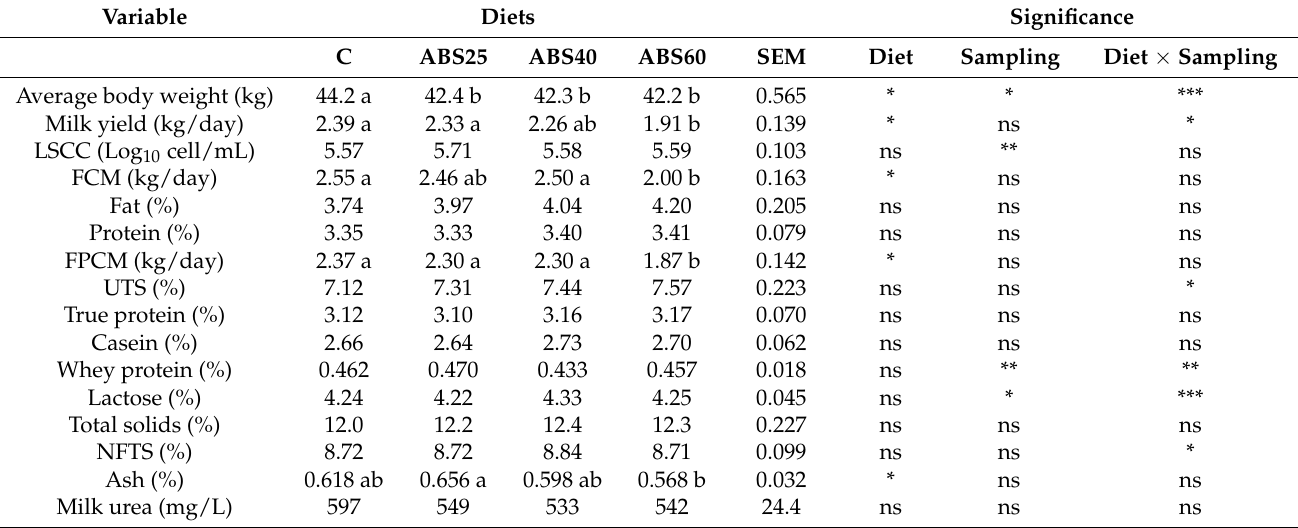
Table 2. Body weight, milk yield and composition and SCC, according to the effects